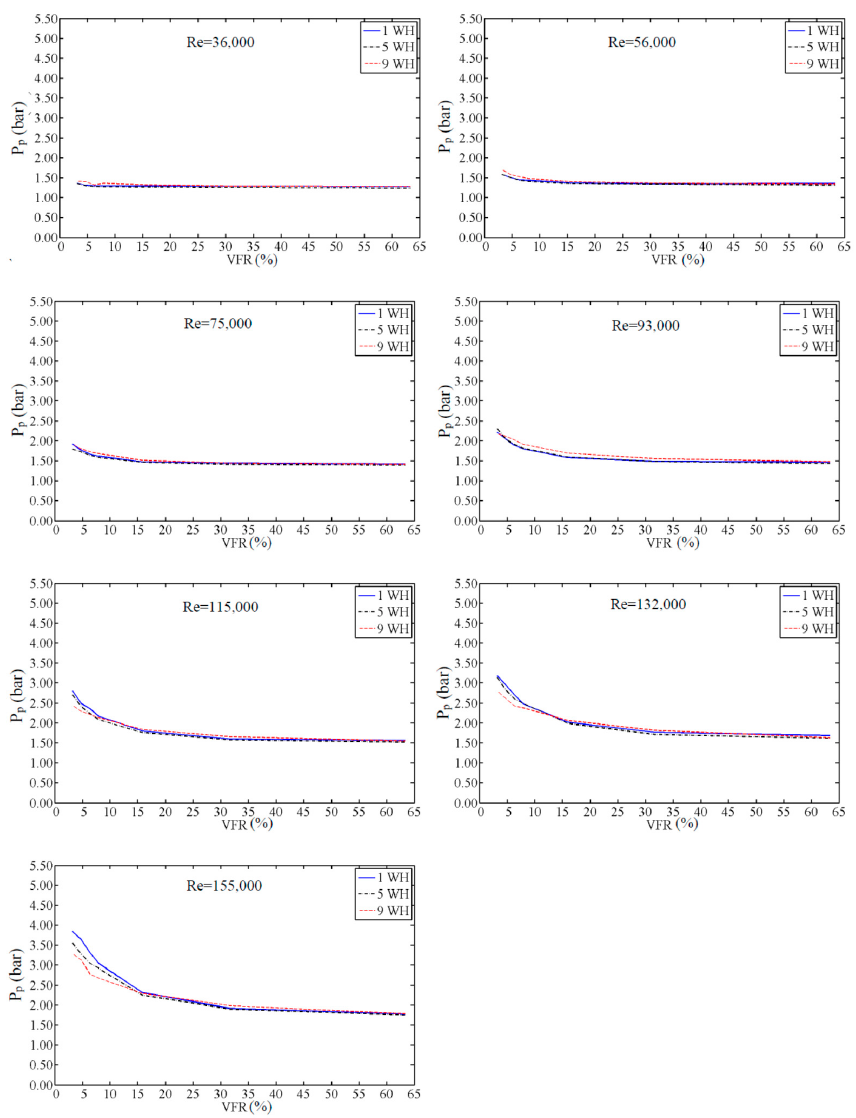
Figure 8. Pressure change inside the pipe at PT 2 against the VFR for different Re and WH events.